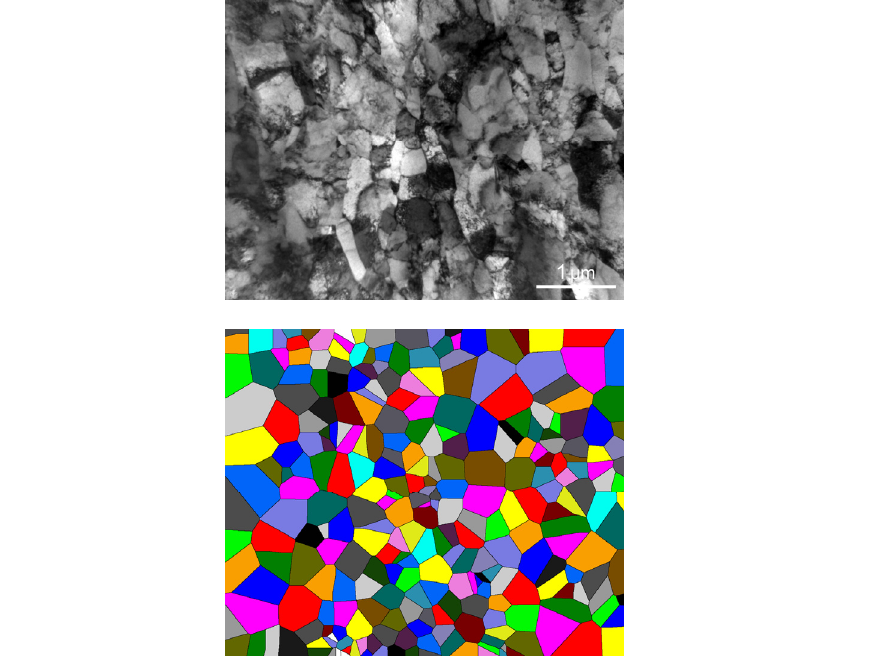
Figura 16: Microfrafia TEM di una lega di rame a struttura ultrafine del grano e tassellatura Voronoi statisticamente